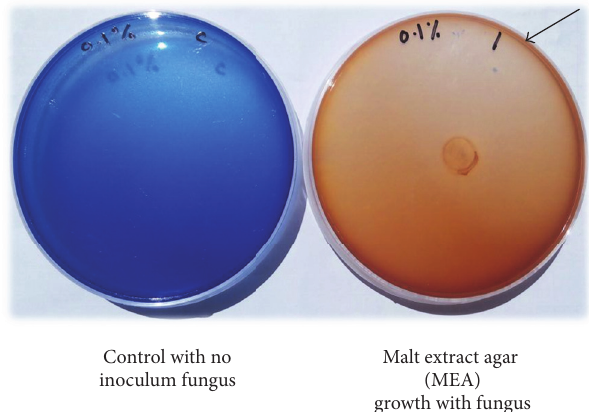
Table 2: Plackett-Burman range and the levels of the variables.